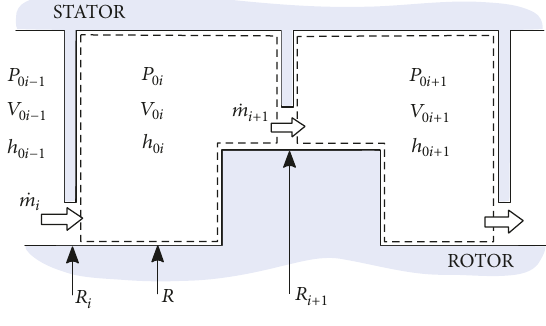
Figure 2: Bulk-flow control